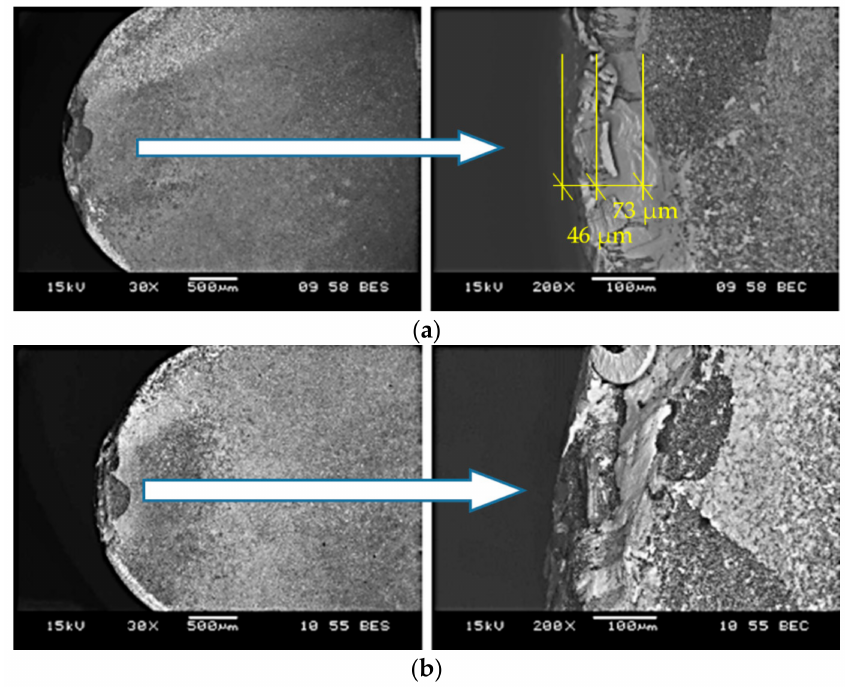
Figure 6. Sample photos of the cutting edge wear on the rake surface of the cutting insert ( a ) v c = 160 m/min; f = 0.048 mm/rev; a p = 0.5 mm, ( b ) v c = 200 m/min; f = 0.048 mm/rev; a p = 0.5